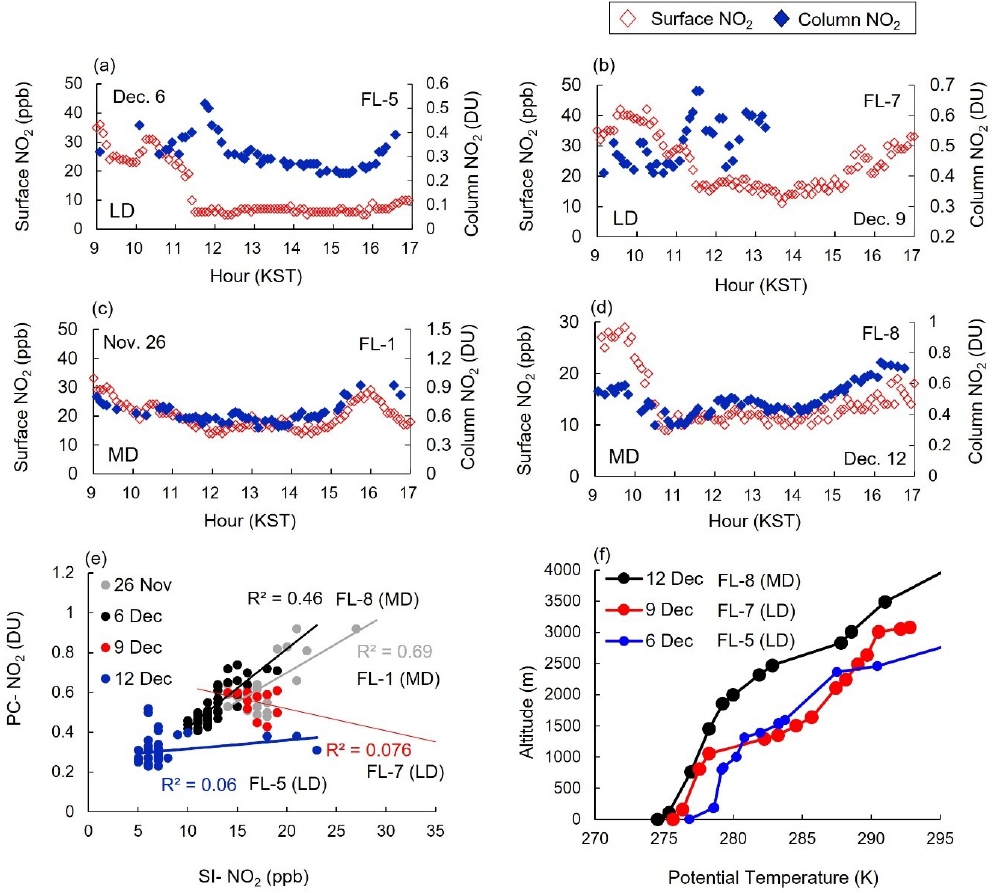
Figure 9. Time series and scatterplots of PC-NO 2 and SI-NO 2 at PA 2 on (a) 6 December, (b) 9 December, (c) 26 November, and (d) 12 De- cember. (e) Scatterplot of PC-NO 2 and SI-NO 2 on 6 December (blue), 9 December (red), 26 November (gray), and 12 December (black). (f) Vertical potential temperature profiles on 6, 9, and 12 December 2020. Radiosonde data for 26 November 2020 are missing.